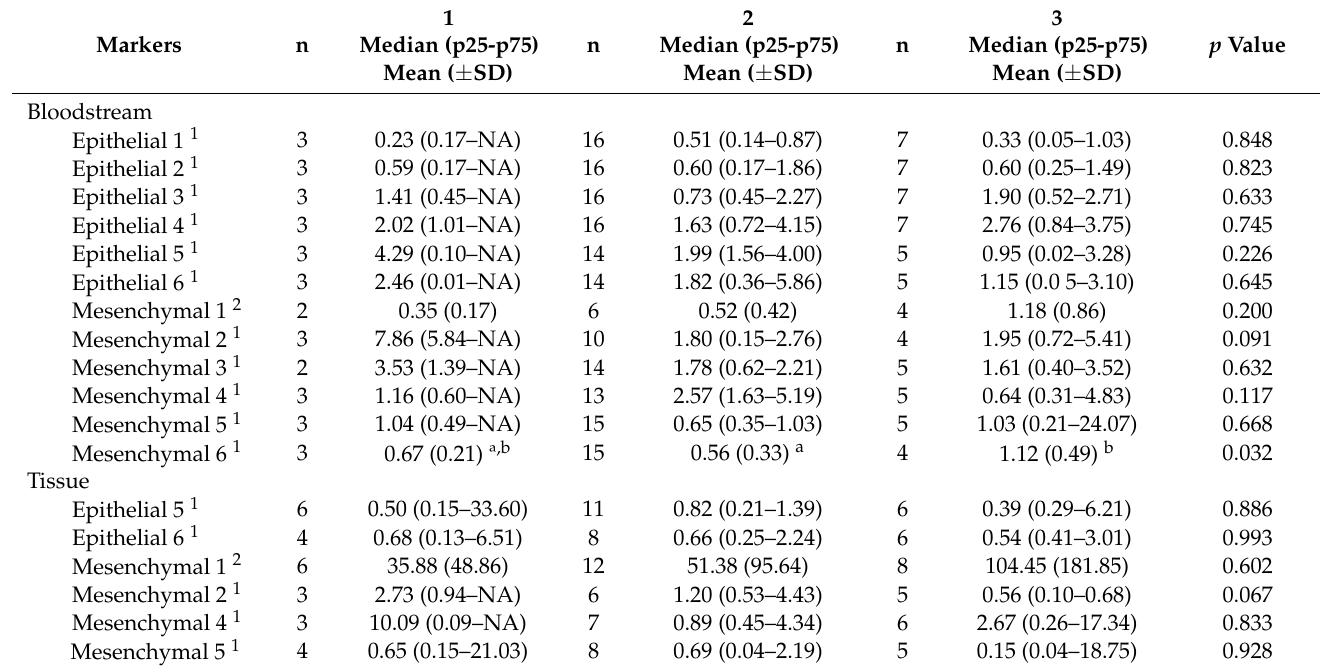
Table 5. Comparison of means between transcriptional levels of the target genes and tumor differentiation